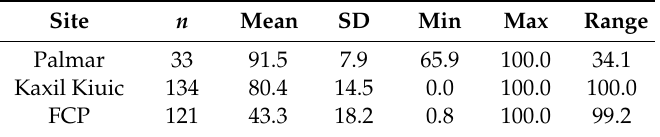
Table 2. Summary statistics of the tree species deciduousness weighed by basal area sampled at field in 1 ha forest inventory plots, measured as percentage.